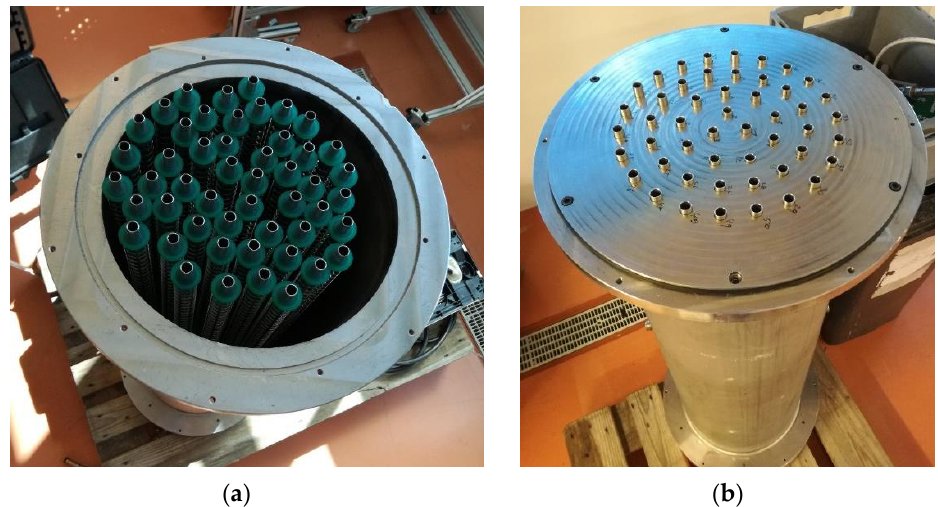
Figure 2. The AHP-coated tube adsorber: ( a ) without the sealing metal joint; ( b ) with the sealing metal joint.